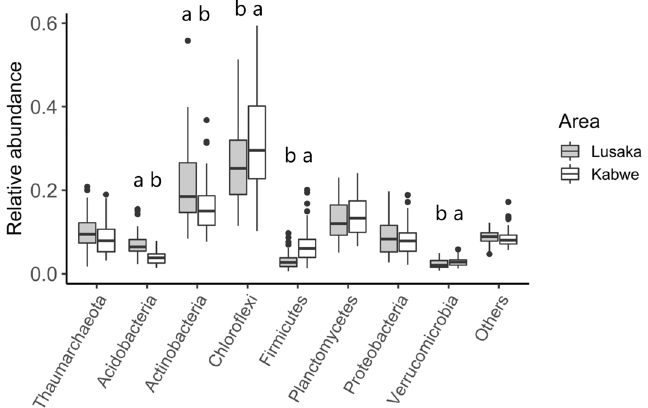
Figure 6. Relative abundances of prokaryotic phyla at the Lusaka and Kabwe sites when averaged across treatments. Phyla with an abundance < 2% were grouped as “others”. Different letters indicate significant differences ( p < 0.05) between the Lusaka and Kabwe sites.